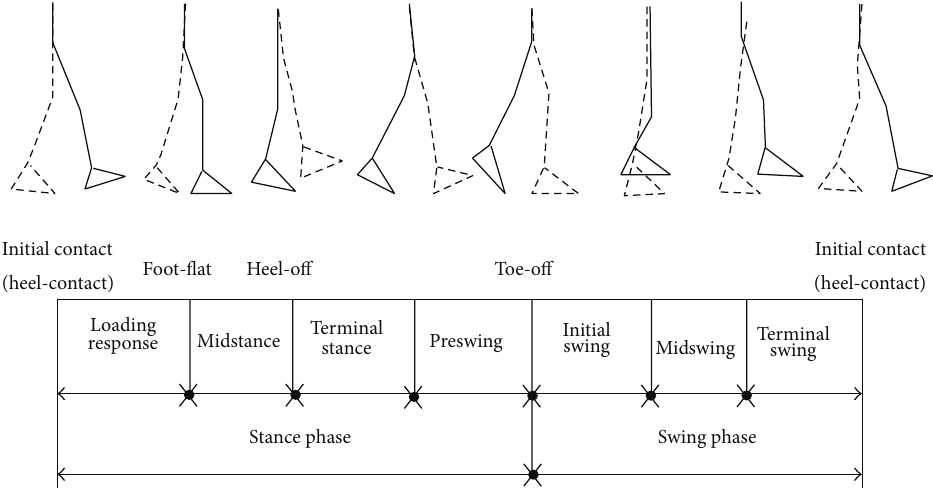
Figure 1: Different phases of normal gait